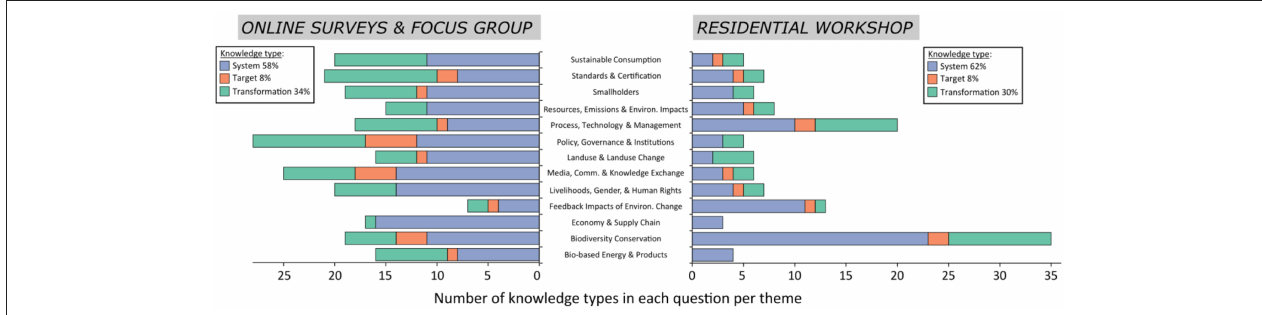
FIGURE 5 | Proportion of research questions as categorized by “knowledge type” in each theme. Research questions derived from the online surveys and focus groups are shown on the left and research questions derived from the residential workshop on the right. In the online surveys and focus groups the knowledge type as a proportion: Systems knowledge (58%), Target knowledge (8%), and Transformation knowledge (34%). In the residential workshop knowledge type as a proportion: Systems knowledge (62%), Target knowledge (8%), and Transformation knowledge (30%). Individual questions could be assigned more than one knowledge type depending on its